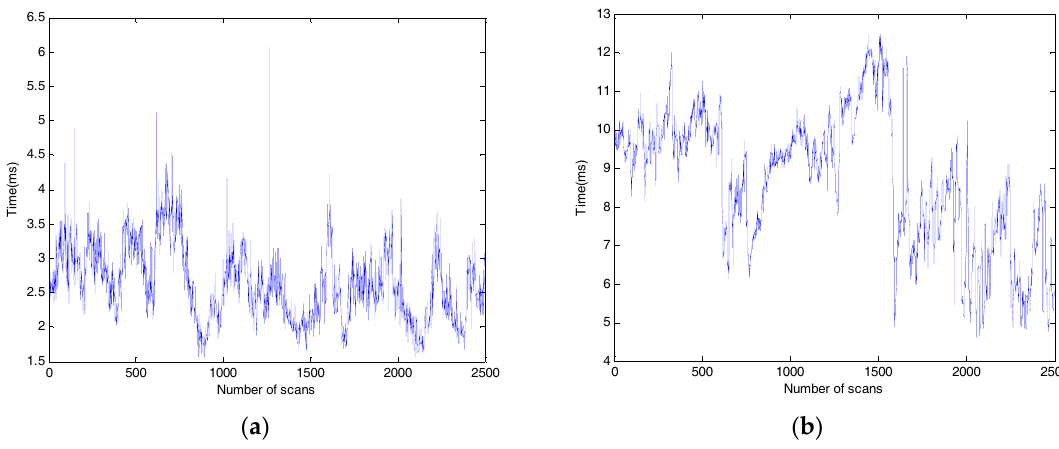
Figure 14. The computing time of our method and Blas’s method. ( a ) Our method; ( b ) Blas’ method.